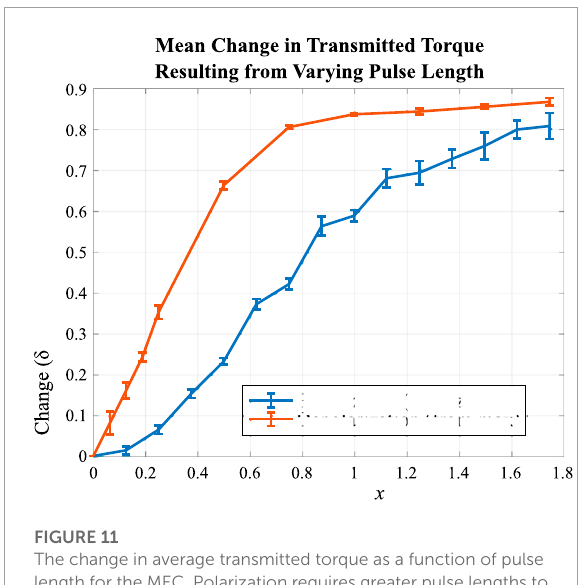
FIGURE 11 The change in average transmitted torque as a function of pulse length for the MEC. Polarization requires greater pulse lengths to achieve the largest possible transmitted torque, while depolarization can have larger changes with shorter pulse